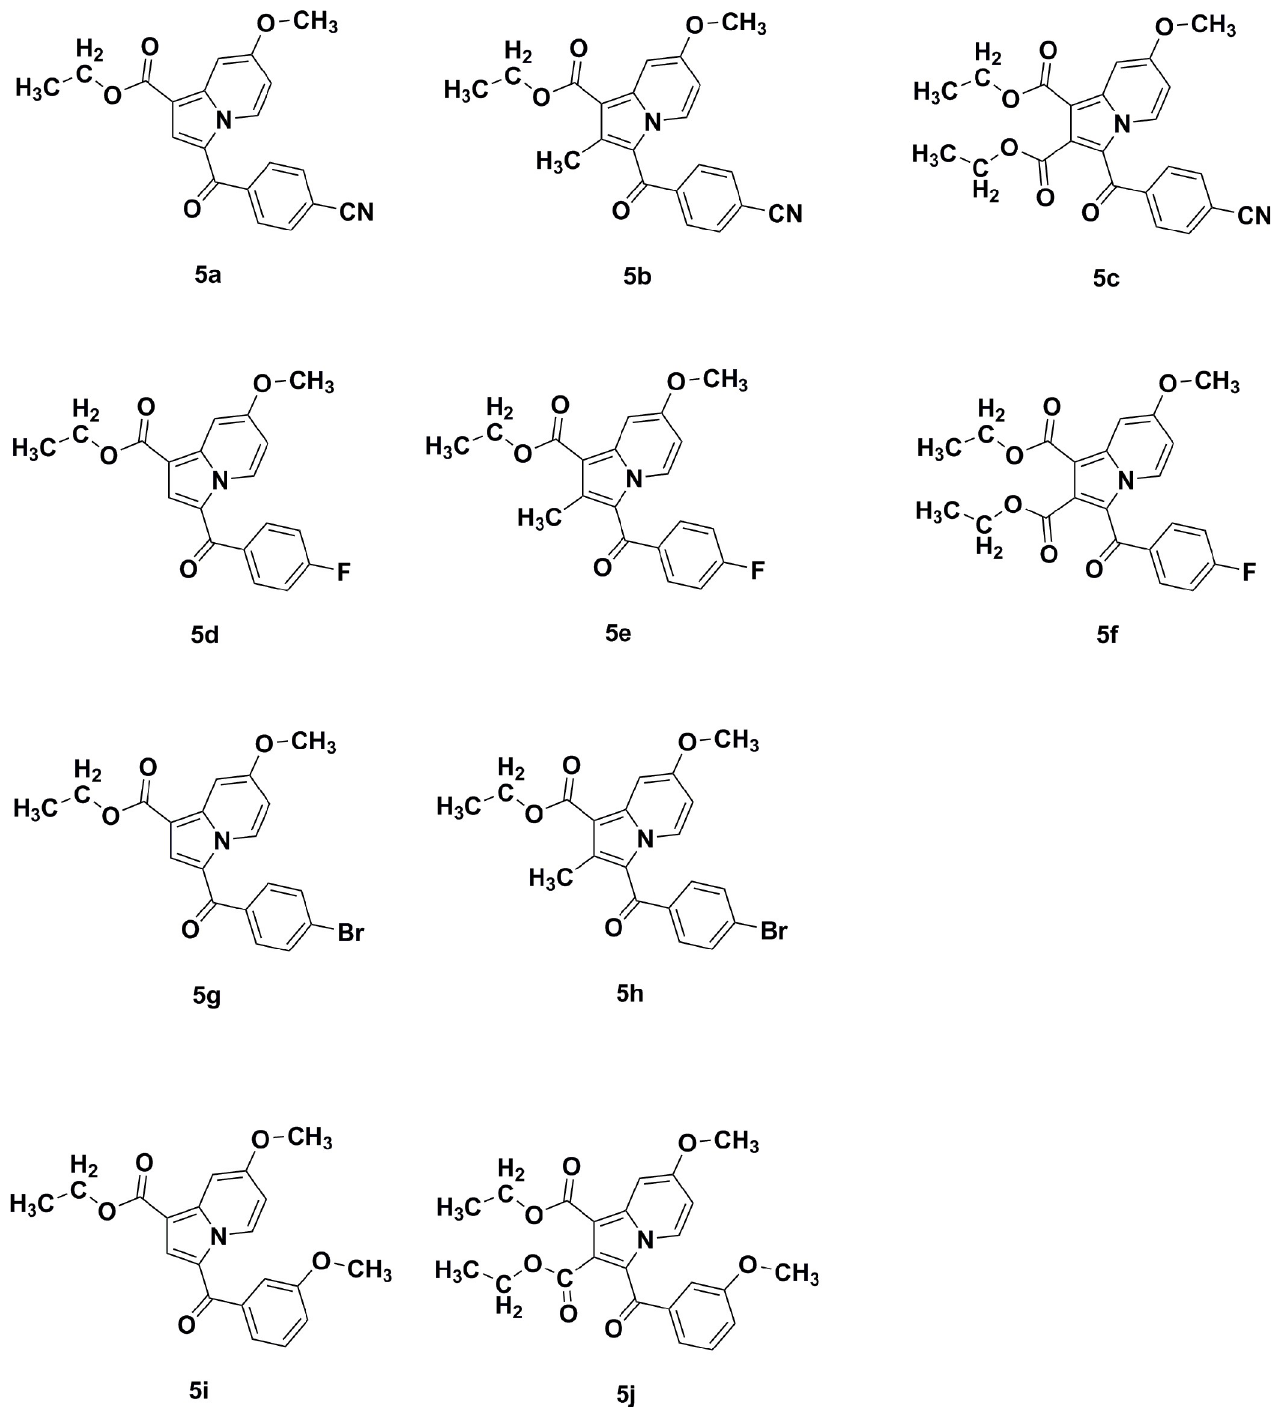
Fig 3. Chemical structures of substituted 7-methoxy-indolizine analogues tested for their anti-TB activity against H37Rv and MDR MTB strains.